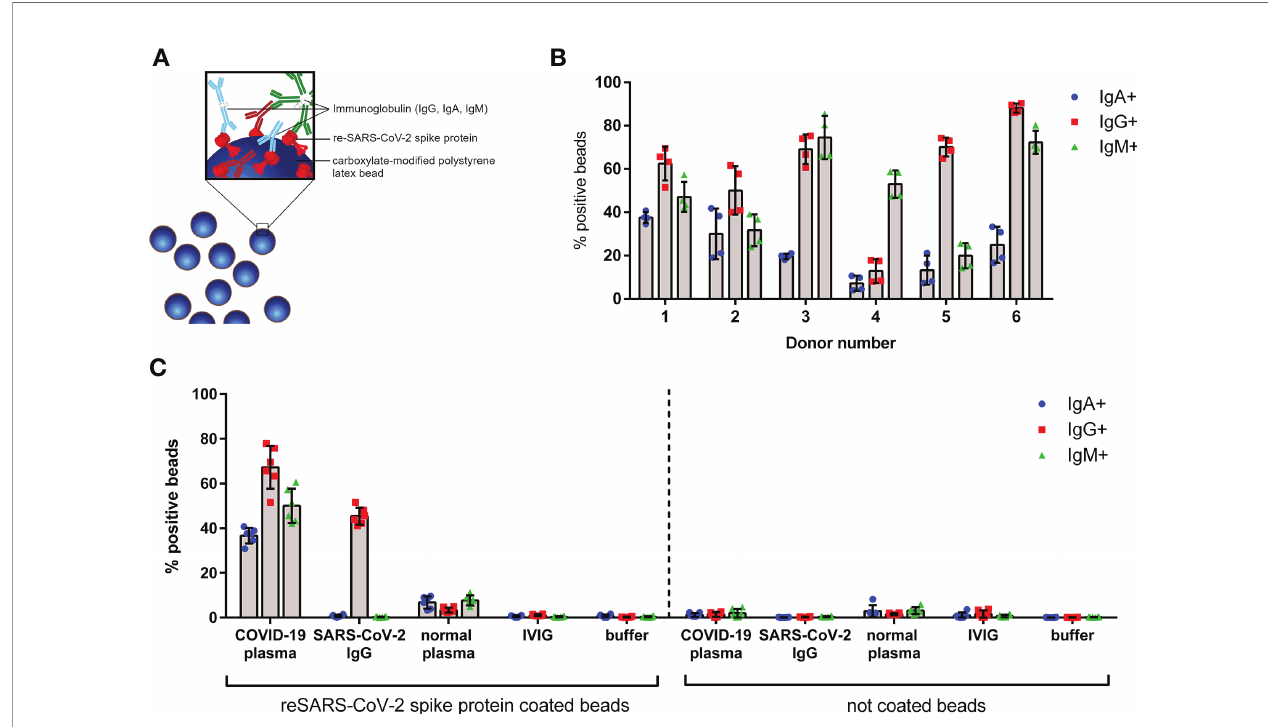
FIGURE 1 | Characterization of SARS-CoV-2-like particles. (A) Schematic overview of fl uorescent latex beads coated with recombinant (re-) SARS-CoV-2 spike protein; speci fi c immunoglobulins of IgG (red), IgA (blue), and IgM (green) classes bound to the spike protein are shown. (B) IgG, IgA, and IgM bound on surface of SARS-CoV-2-like latex beads opsonized with different convalescent COVID-19 plasma donations (donor numbers 1 – 6). Coated beads were incubated with plasma from indicated donors for 45 min at 37°C. After washing, beads were stained with anti-IgG, anti-IgA, and anti-IgM detection antibodies and analyzed by fl ow cytometry. Percentage of positive beads for IgG, IgA, and IgM is shown; data represents mean of four independent experiments. (C) Control experiments show speci fi c binding of anti-SARS-CoV-2 antibodies to spike protein. Coated or non-coated beads were incubated with indicated plasma, immunoglobulins, or buffer for 45 min at 37°C and were stained as described in (B) . Data represents mean of six independent